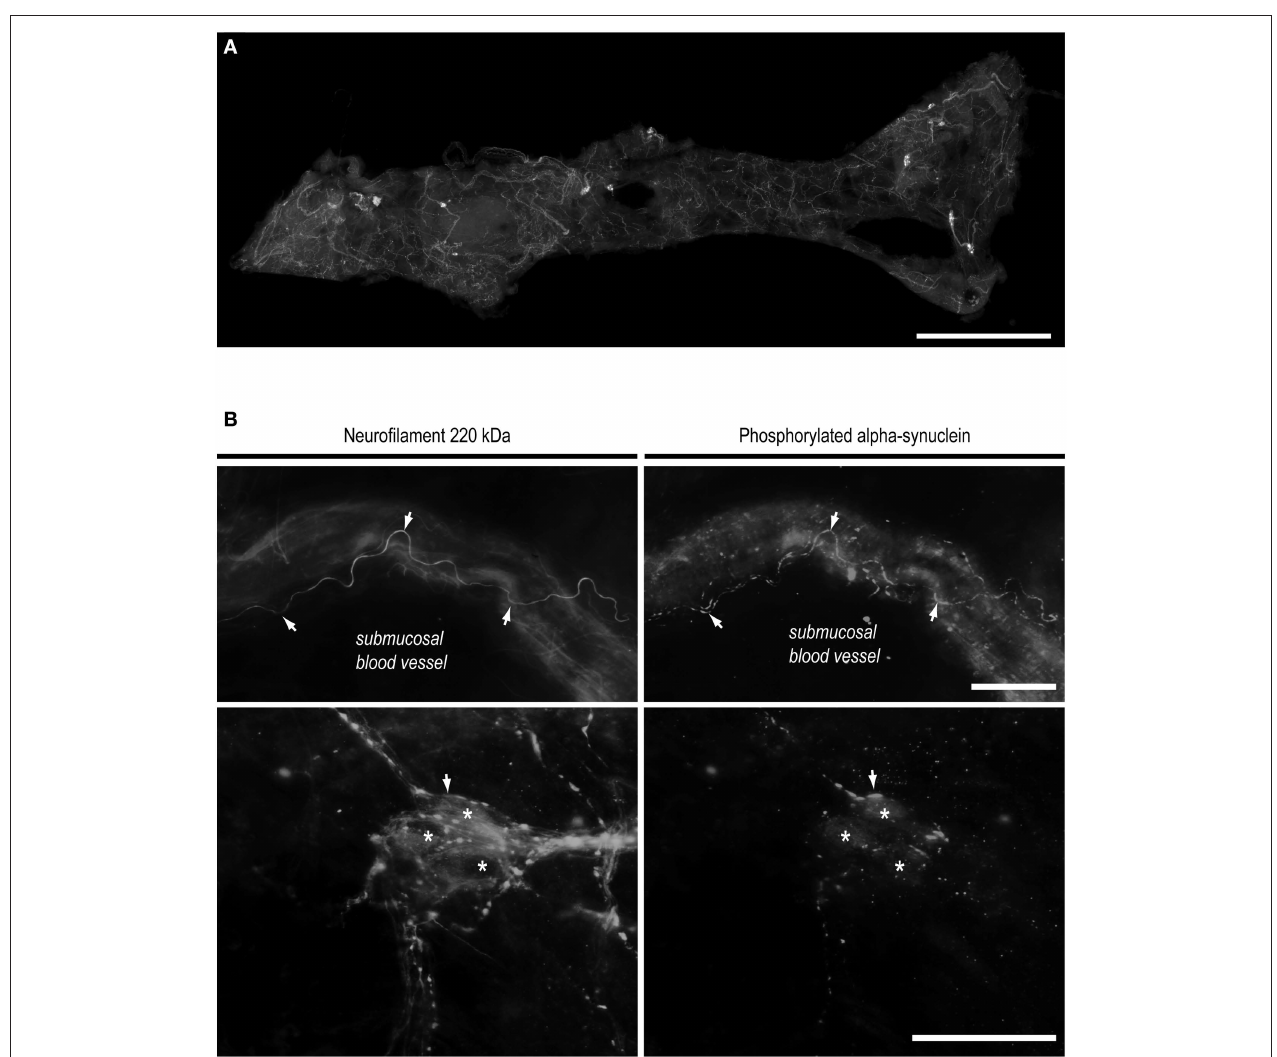
Figure 2 | routine colonoscopy biopsies as a novel biomarker of Parkinson’s disease. (A) Whole mount of submucosa microdissected from a standard colonoscopy biopsy and immunostained with anti-neurofilament antibody to unravel the neural network. Colonic submucosal (Meissner’s) plexus, formed by ganglia and interganglionic strands, is readily apparent. A single biopsy performed in the ascending or descending colon gives access to a mean of 150